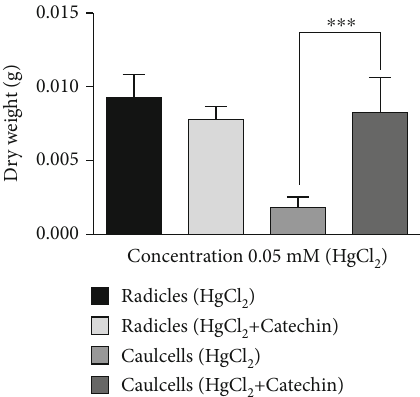
Figure 1: E ff ect of isolated mercury chloride (HgCl association with catechin on the dry mass of radicles and stems of Lactuca sativa .